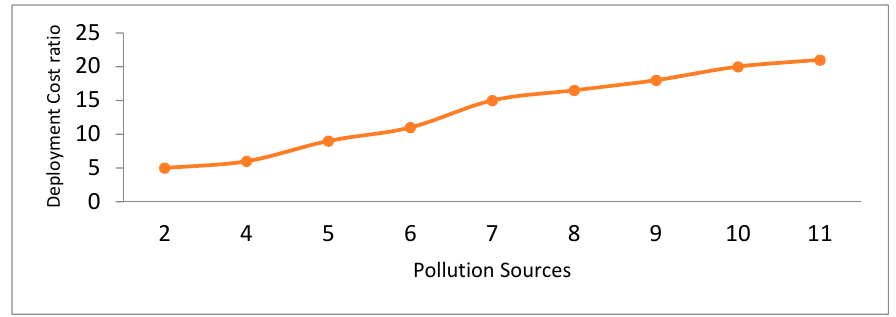
2.5 concentration.